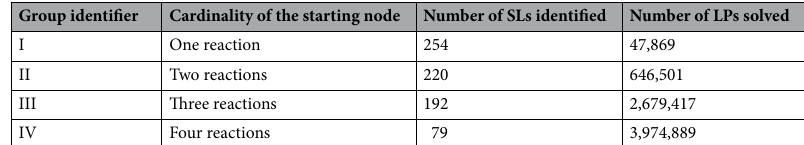
Table 2. The number of SLs and corresponding LPs solved in each group of branches of the Rapid-SL, while searching for single lethals to quadruple SLs in iAF1260. The branches are grouped based on the number of members in their starting node. Evaluating only the first group of branches identifies over 34% of SLs, while only about 0.65% of LPs must be examined.